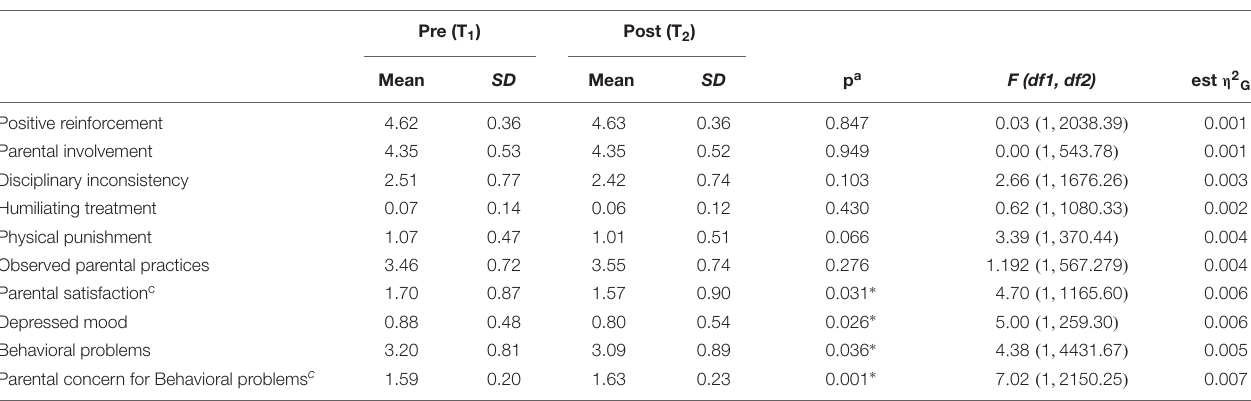
TABLE 2 | Anova results of pre and post evaluation in control group.